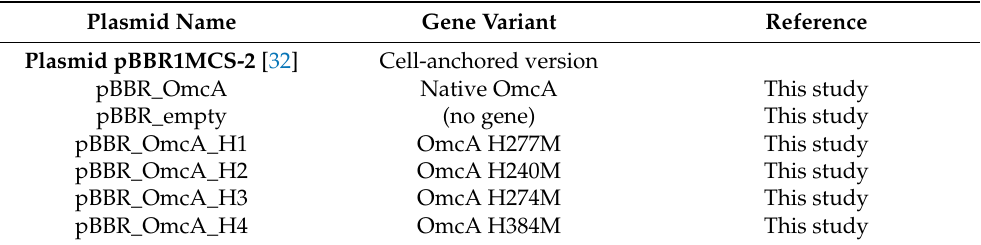
Table 2. List of plasmids used for this